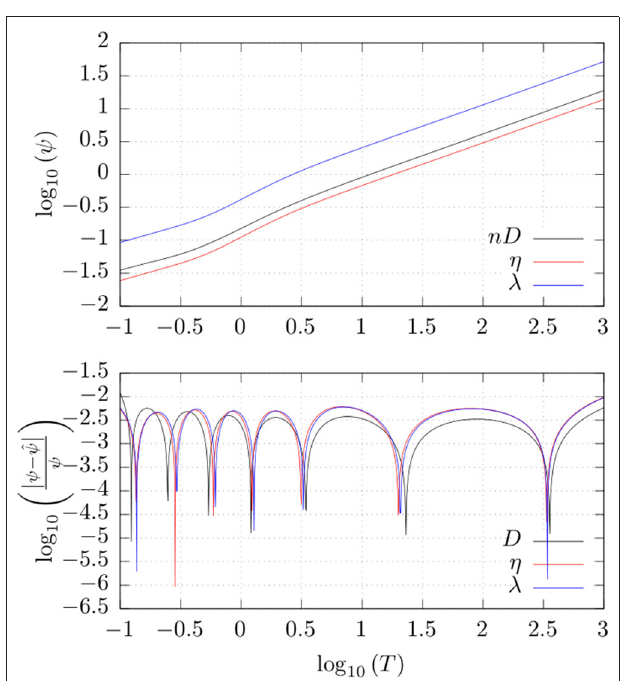
FIGURE 5 | Logscale plot of transport coefficients against kinetic temperature. Bottom: Logscale plot of relative error in the optimized parameterization given by Equation